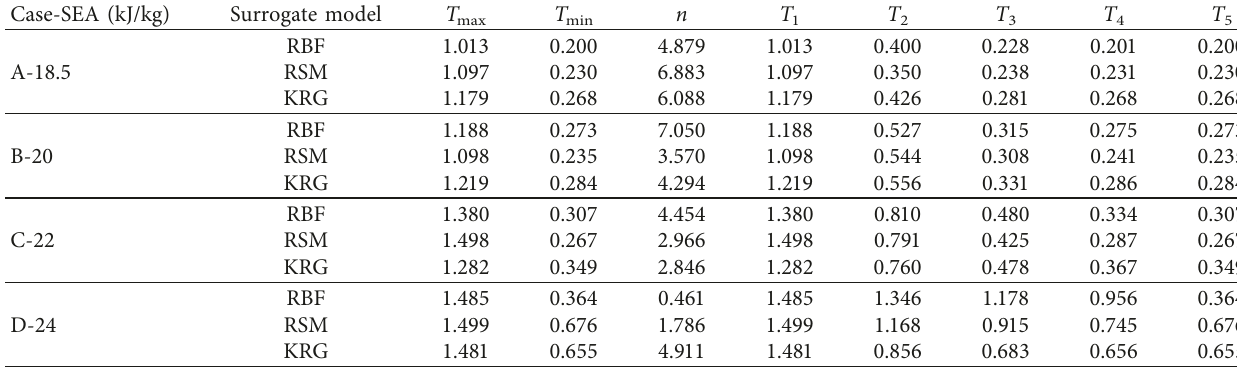
Table 3: Optimal thickness value summary by different surrogate